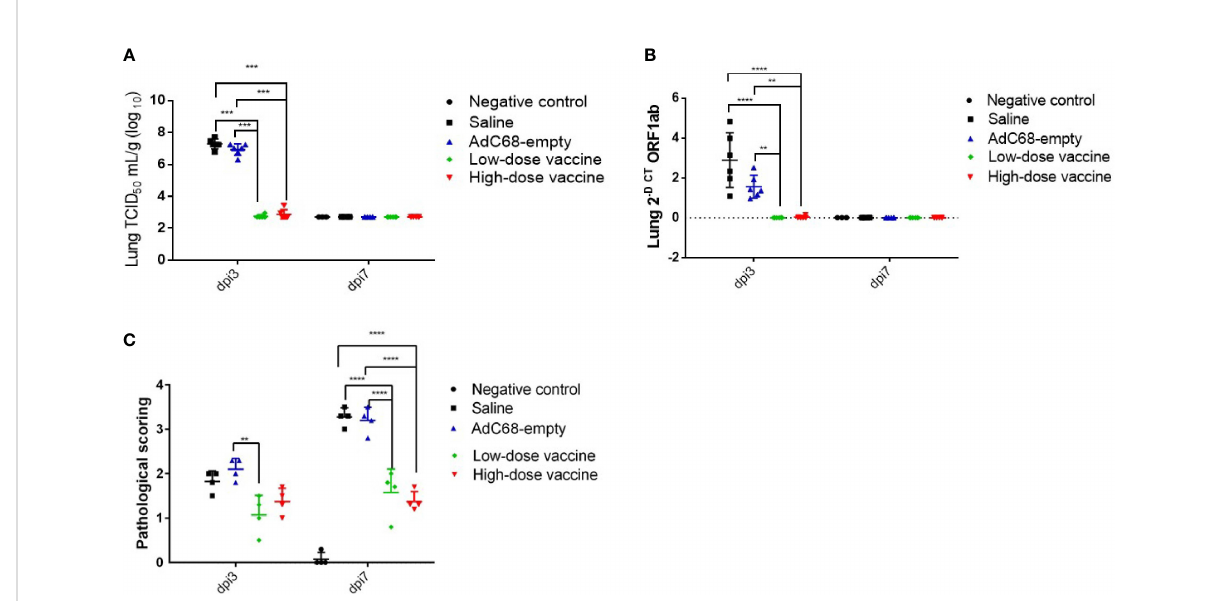
FIGURE 6 Intranasal BV-AdCoV-1 vaccination protects golden Syrian hamsters from SARS-CoV-2 infection. (A) SARS-CoV-2 virus infection titers in the lungs of golden Syrian hamsters were de fi ned as the virus 50% tissue culture infectious dose (TCID 50 ). (B) SARS-CoV-2 relative levels of RNA in the lungs of golden Syrian hamsters. (C) Lung histopathology scores in golden Syrian hamsters. Left lung slides were stained with Hematoxylin- Phloxine to visualize histomorphometric changes. Slides were scanned using the NanoZoomer Digital Pathology System C9600-02. ** p < 0.01, *** p < 0.001, **** p <